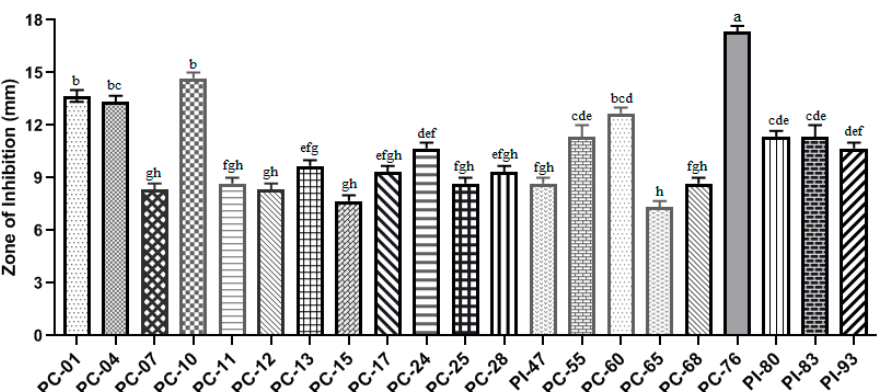
Figure 2. Anti- Salmonella Gallinarum activity of cell free supernatants of lactobacilli. a–h Bars represented with the same alphabet shows the non-significant difference ( p > 0.05) between isolates while bars with different alphabets show the significant difference ( p < 0.05) between isolates.